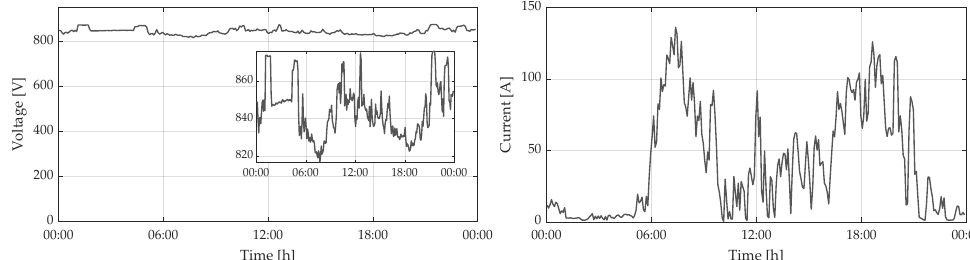
Figure 8. Voltage ( left ) and current ( right ) measurements in TS T-T in an average window of 5 s. The plots cover a 24-h simulation scenario.